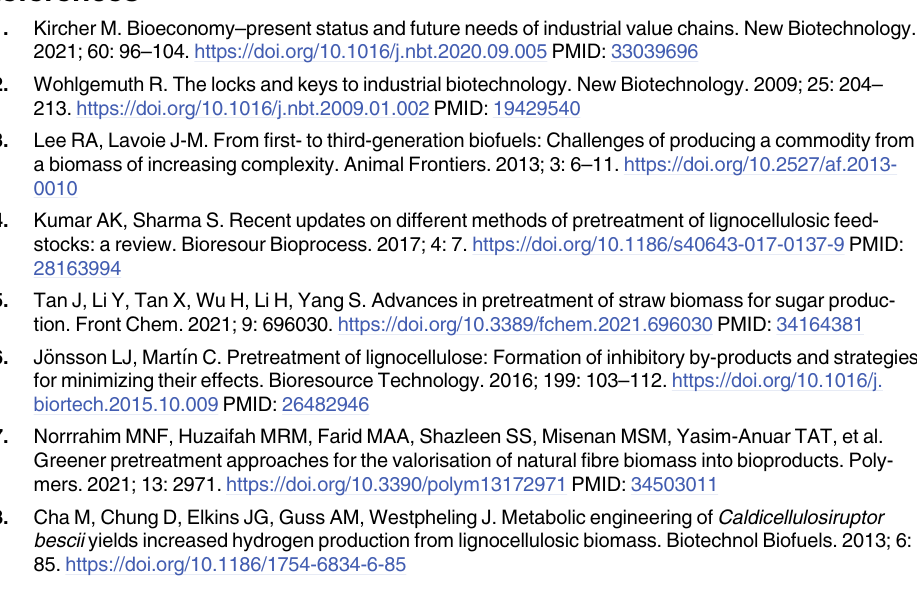
S5 Fig. Digestion of genomic DNA of strain DIB 104C and strain BluCon085 with the restriction endonucleases DpnI and SexAI. A restriction digest without restriction endonu- clease was included as control. S1 Table. List of primers used in this study. The names of the restriction endonucleases are given in brackets and the corresponding recognition sequences are indicated with an under- line. Phosphorothioate nucleotide linkages are indicated with an